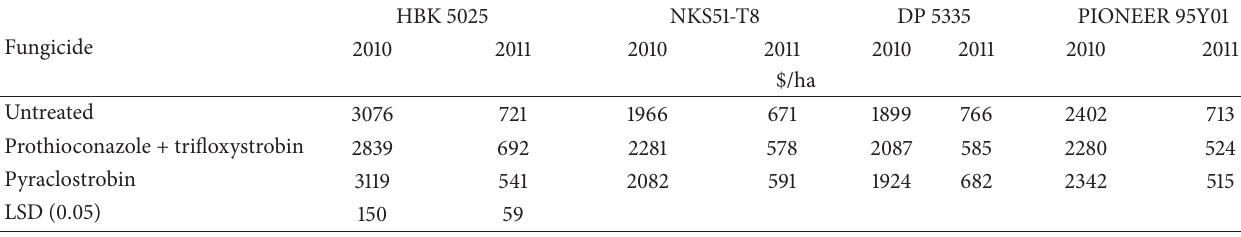
Table 3: Net return per hectare based on the use of fungicides under no disease pressure a,b